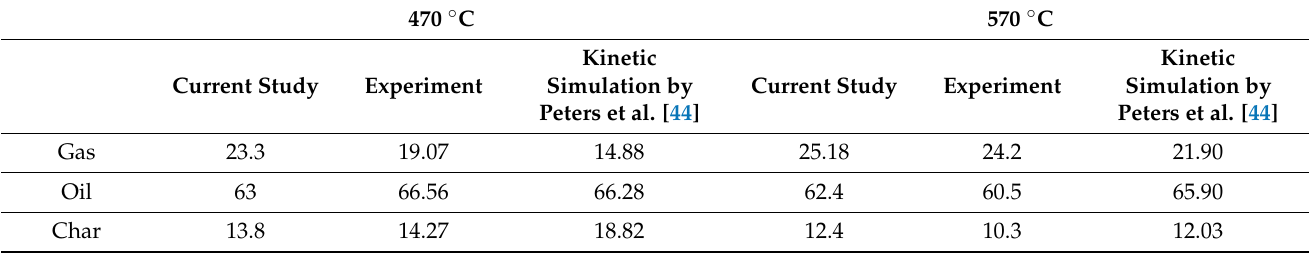
Table 10. Comparison of product yields for beech wood (%).